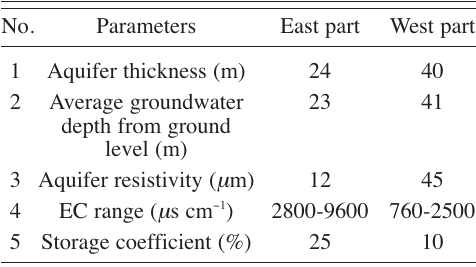
Table I. Hydraulic parameters of the